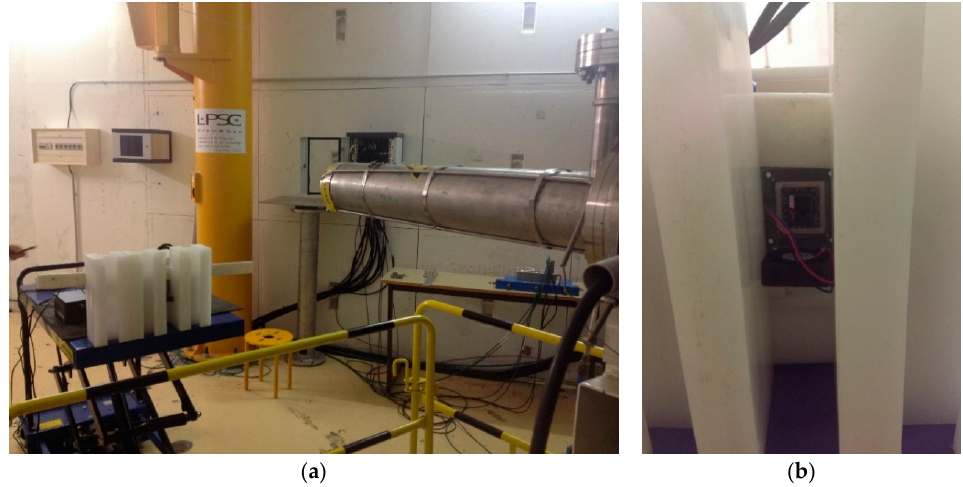
Figure 5. ( a ) Experimental Set-up at GENEPI2; ( b ) MPPA target device.